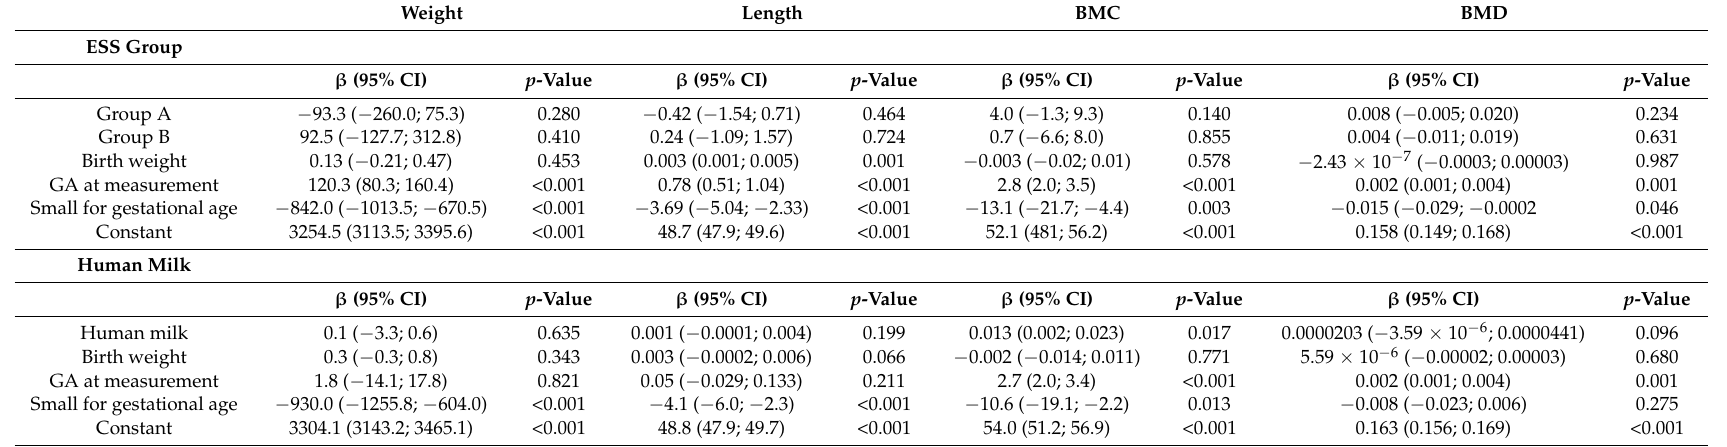
Table 5. Associations between group assignment and human milk and outcomes at term corrected age.